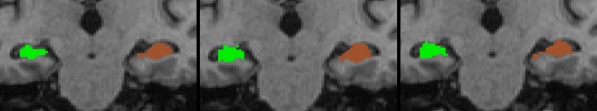
Left and right hippocampus segmentations in coronal view.Left: manual segmentation. Middle: FSL-FIRST segmentation. Right: FreeSurfer segmentation.